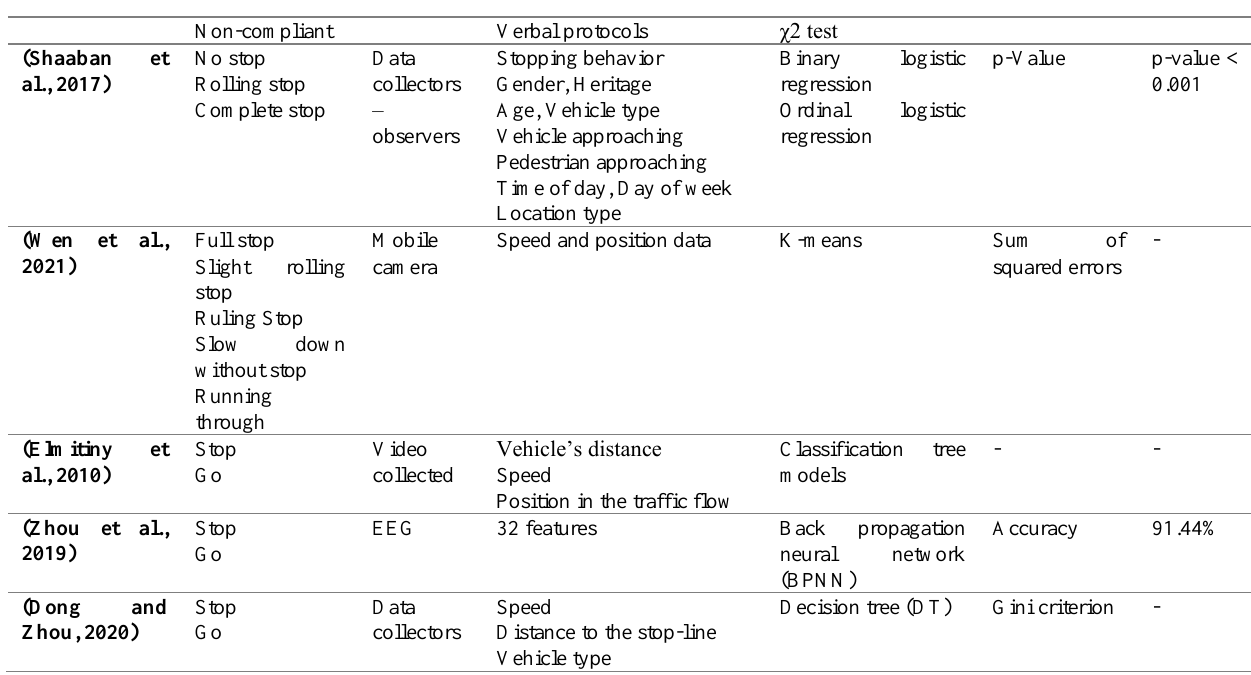
Table 1 . Statistical description of independent